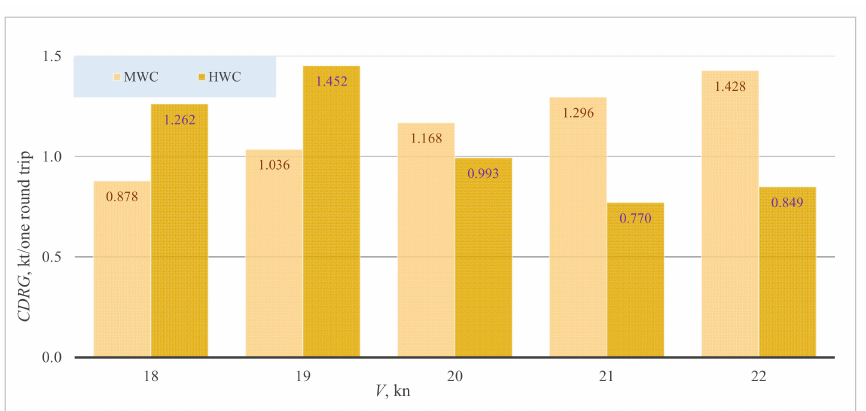
V S max ( S 5 ) ≤ 20.393 kn and V S max ( S 6 ) ≤ 19.163 kn, the maximum value of CO 2 emission